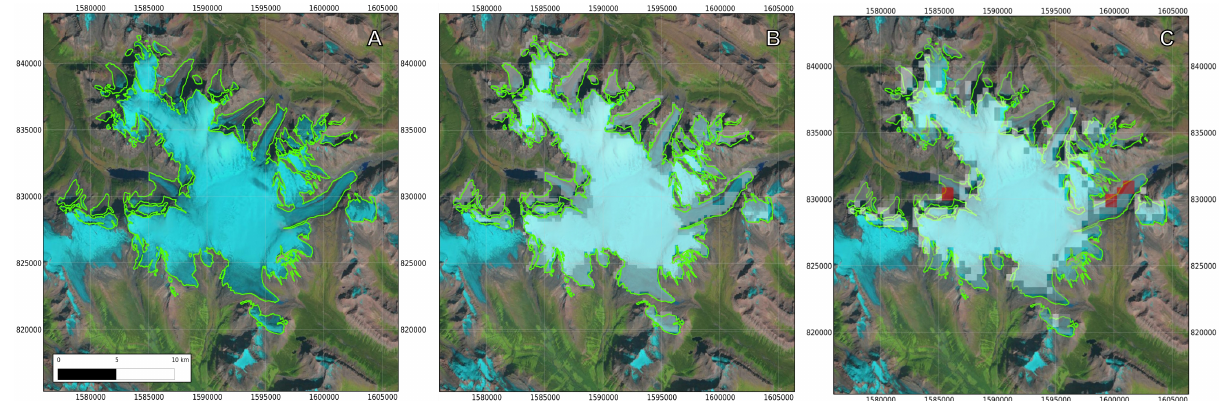
Fig. 2. (A) Landsat 5 scene of Columbia Icefield, 29 August 2009, with (B) corresponding MOD02 snow (white) and ice (grey) clusters, and (C) MOD10 snow cover product. Cloud-obscured pixels in (C) are shown in red. Map coordinates are in metres, and refer to the BC Albers projection.